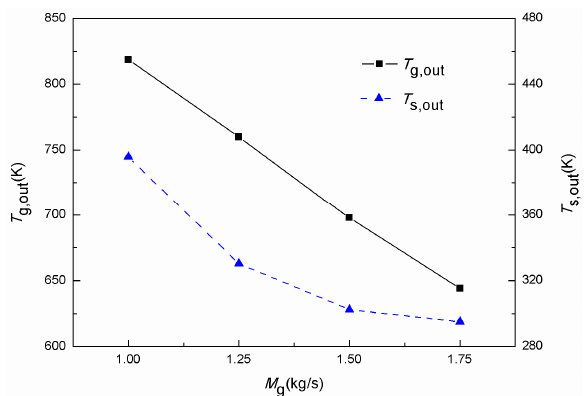
Figure 5. Influence of the air flow rate on the outlet air temperature and outlet sinter temperature.